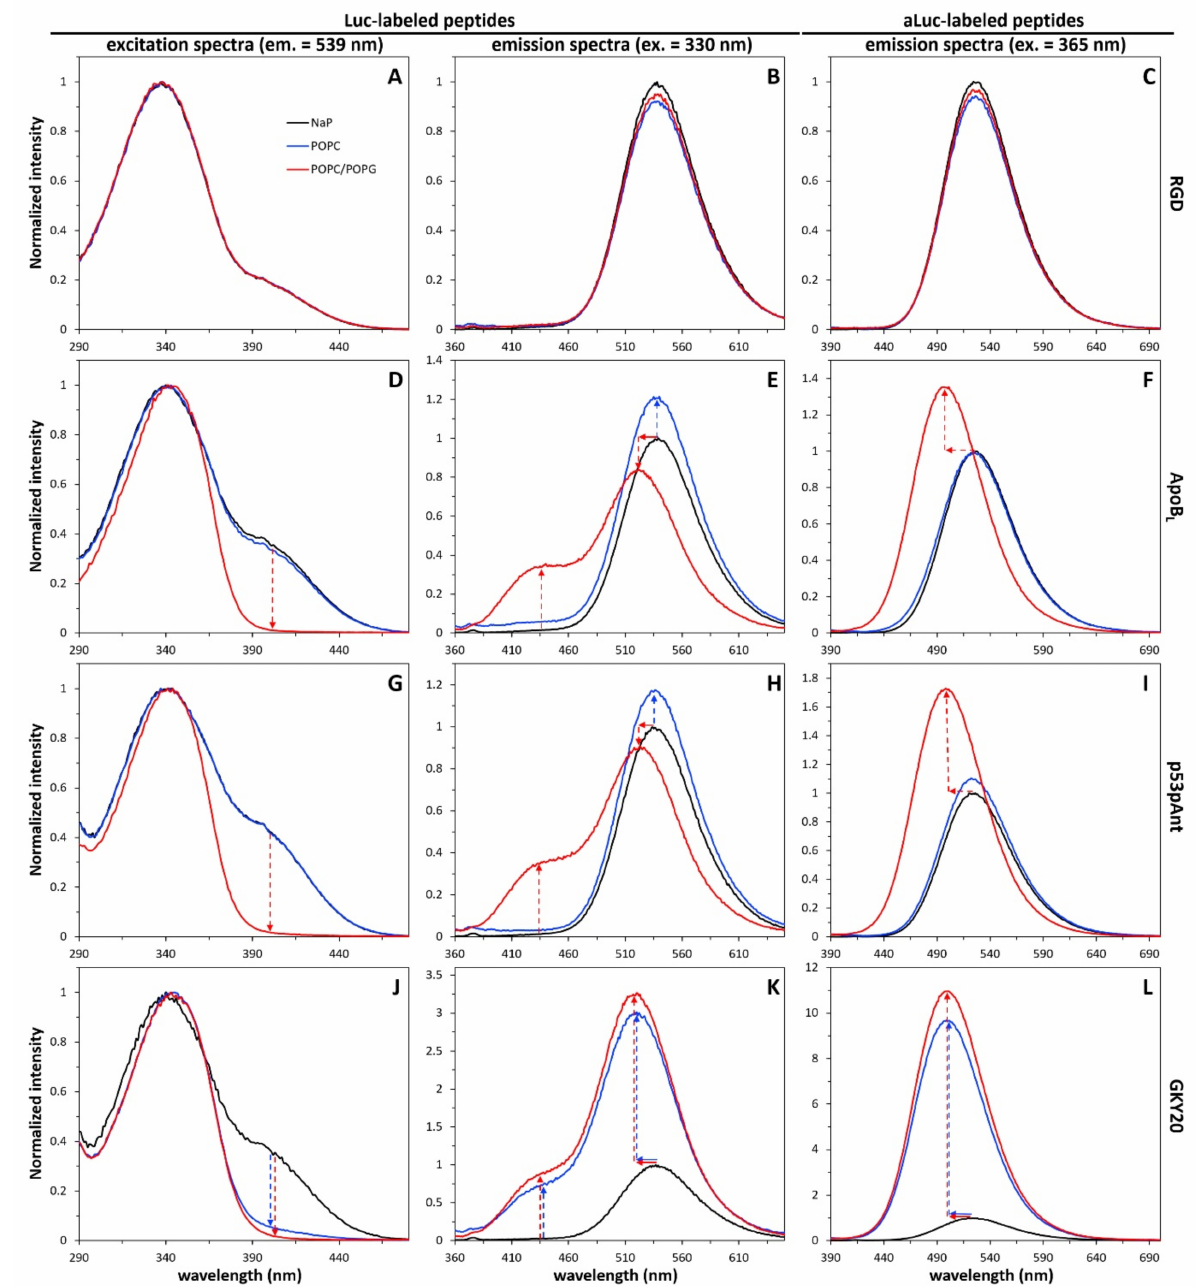
Figure 2. Fluorescence of labeled peptides in the presence of liposomes of POPC or POPC/POPG (5:1). Excitation spectra of luciferin (left), emission spectra of luciferin (center) and emission spectra of aminoluciferin (right) were recorded for peptides RGD ( A–C ), ApoB L ( D–F ), p53pAnt ( G–I ) and GKY20 ( J–L ). Spectra recorded in the presence of liposomes were normalized to the corresponding spectra in NaP. Arrows highlight the main changes with respect to